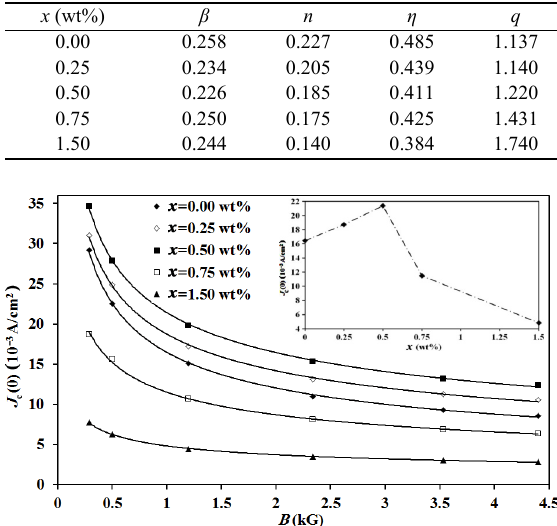
Fig. 9 Relation between critical current density at 0 K and B for (BaSnO 3 ) x /BiPb-2223 samples. The inset shows relation between J c (0) versus x .